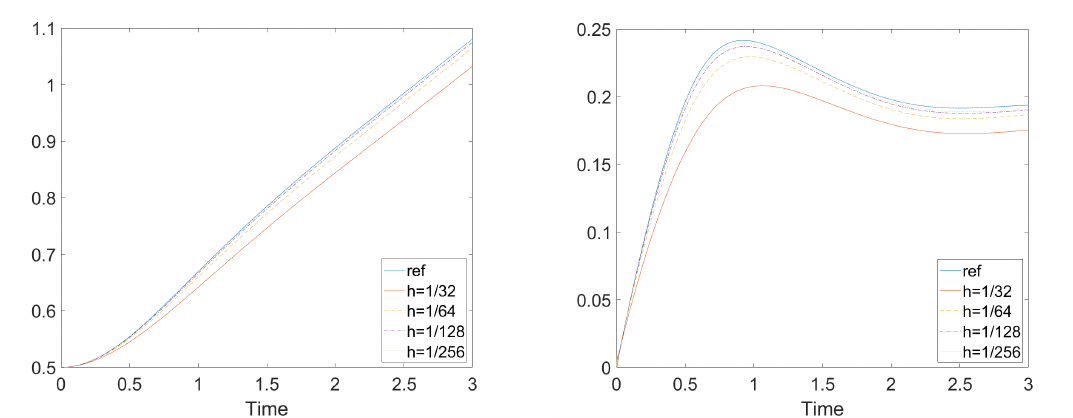
Figure 3. Center of mass (left) and rise velocity (right) over time in comparison to reference results from group 1 in [28].